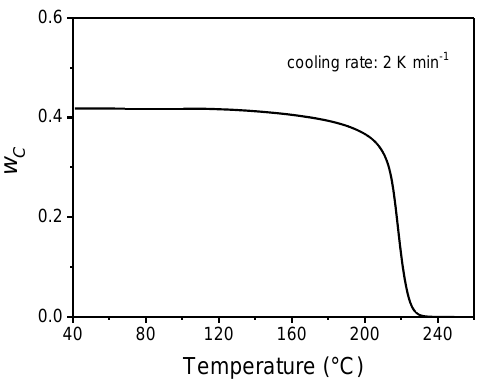
Figure 17. Temperature evolution of the crystalline weight fraction ( w C ) of PET during non-isothermal crystallization at 2 K min −1 . (Reprinted (adapted) with permission from [37]. Copyright (2014) Elsevier).